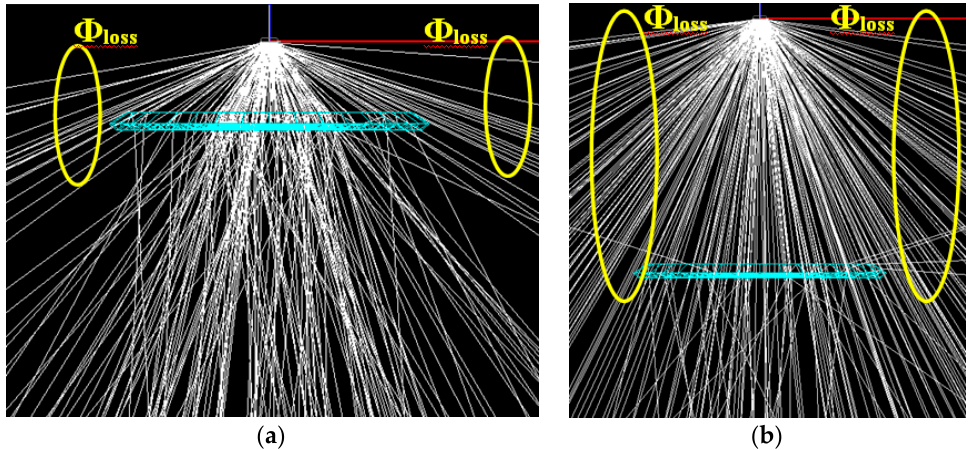
Figure 5. The losses of luminous flux for the changed position of the lens relative to the LED source: ( a ) the lens positioned at a short distance from the source, ( b ) the lens positioned at a long distance from the source.